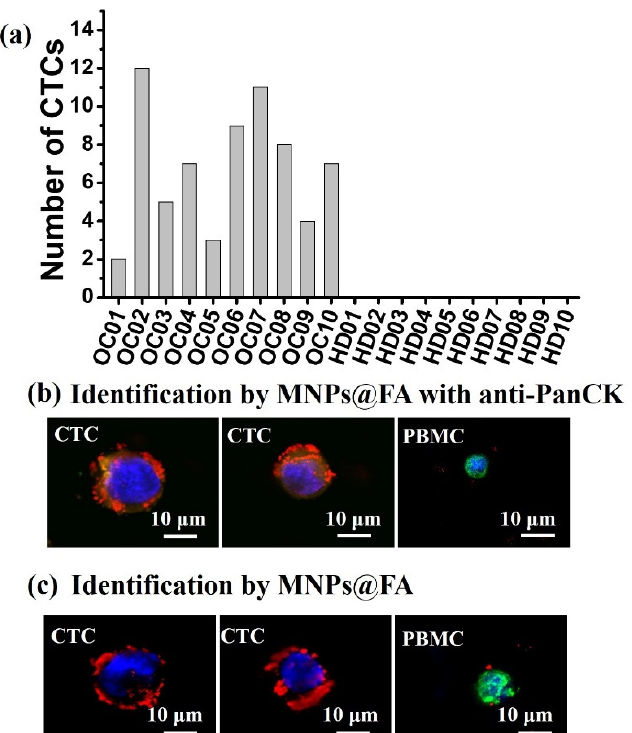
Figure 6. ( a ) Number of CTCs in the blood of 10 ovarian cancer patients (OC) and 10 healthy donors (HD) detected by the MNPs@FA. ( b ) Fluorescent images of CTCs and PBMCs identified by immunostaining of anti-PanCK-555 (orange) and anti-CD45-488 (green) as well as MNPs@FA (red) and Hoechst 33,342 (blue). ( c ) Fluorescent images of CTCs and PBMCs identified by Hoechst 33,342 (blue), anti-CD45-488 (green), and MNPs@FA (red).